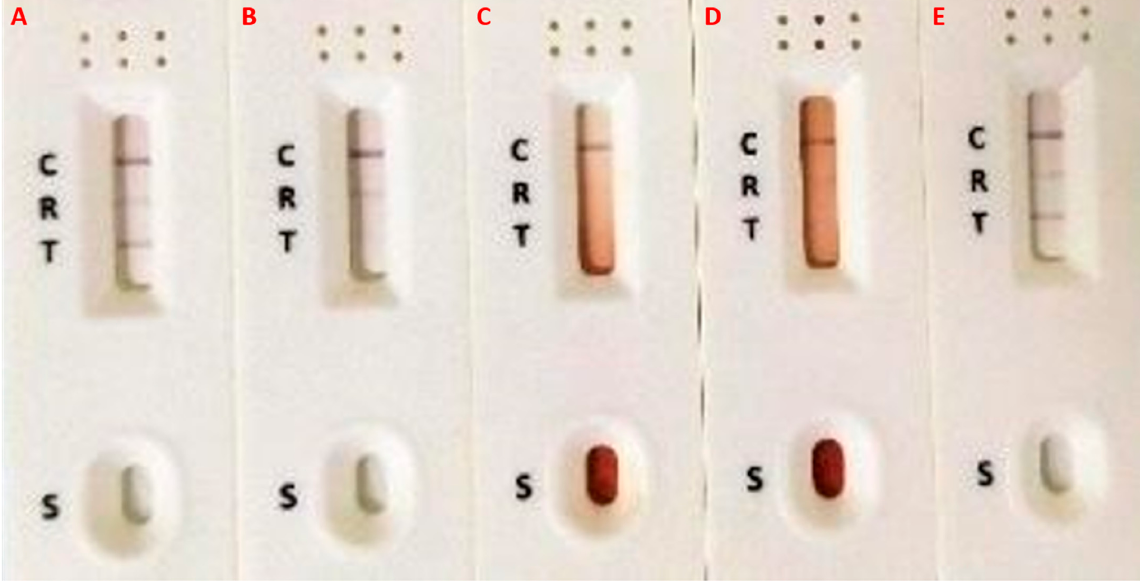
Figure 4. Images of the POC-PSA test conducted on participants with Prostate abnormalities. ( A , E ). Strong positive POC-PSA with no urine or semen eggs and no abnormalities. ( B ). Negative POC- PSA with semen real-time PCR (Ct-value: 25.4), irregular prostate outline and hyperechoic nodule. ( C ). Negative POC-PSA with no urine eggs, but had grossly irregular, enlarged prostate (61.3 mL), abnormal epididymis and bilateral hydrocele. ( D ). Negative POC-PSA with no urine or semen eggs, negative real-time PCR but had irregular, enlarged prostate (39.1 mL).